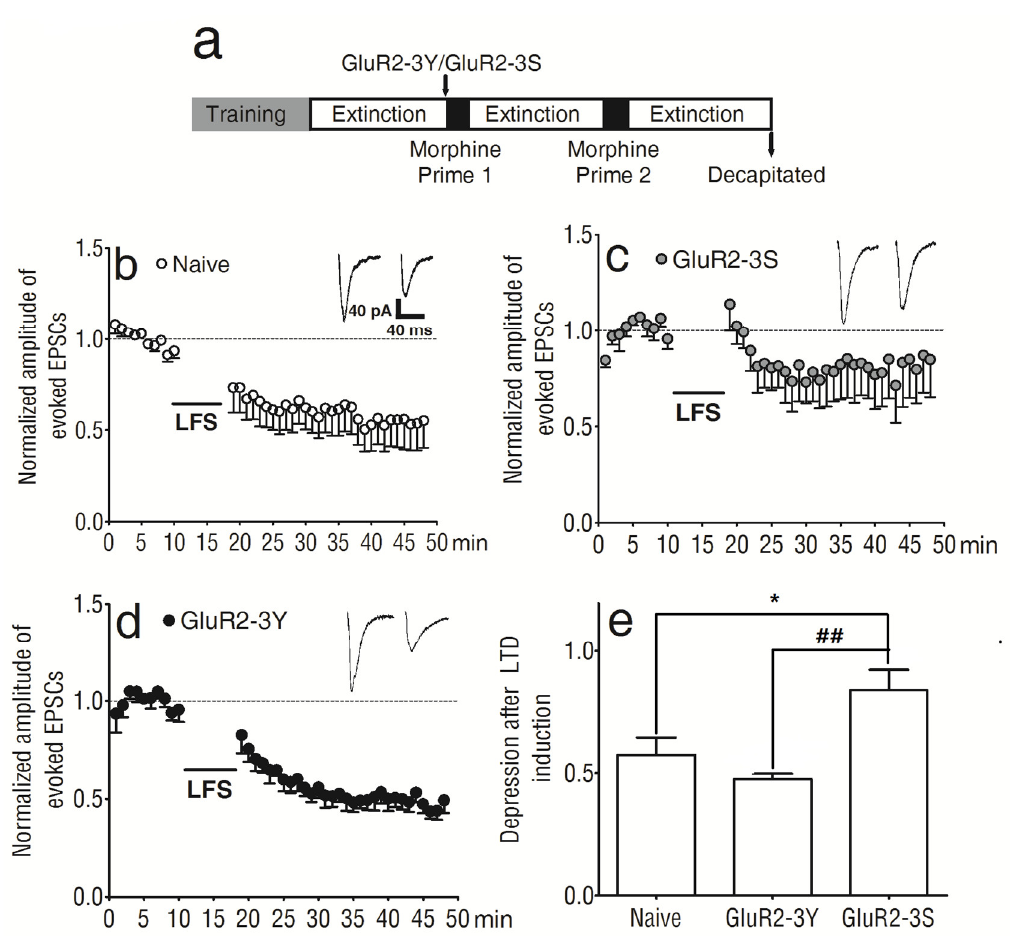
Figure 3. Intravenous injection of GluR2-3Y altered LTD in the NAc shell. ( a ) Experimental protocol. ( b ) Expression of LTD in the NAc of naive rats. ( c ) Expression of LTD in the NAc of animals treated with GluR2-3S. ( d ) Expression of LTD in the NAc of animals treated with GluR2-3Y. ( e ) Bar graphs summarizing the data for the last 5 min of LTD induction from experiments such as those shown in ( b – d ). ## p < 0.01 versus the GluR2-3S group, * p < 0.05 versus the naive group (Bonferroni post-test). Data are expressed as mean ± s.e.m. (n = 6–8 per group).